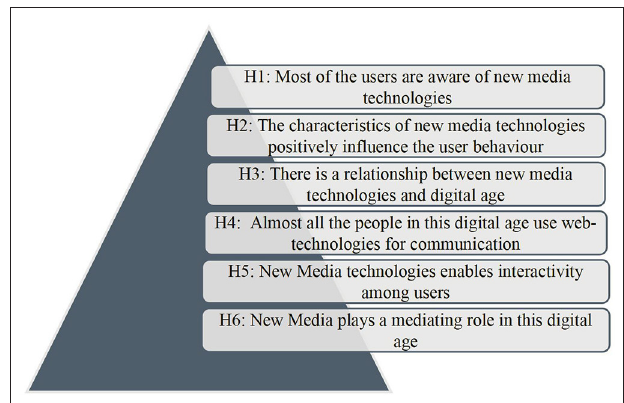
FIGURE 1 | Proposed hypotheses of the